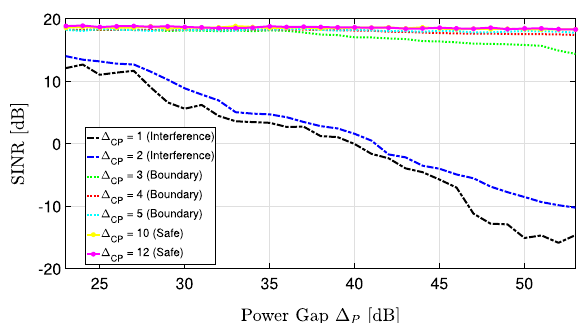
1,2,3,4,5,10,12 and varying the power gap (cid:31) p . We { }